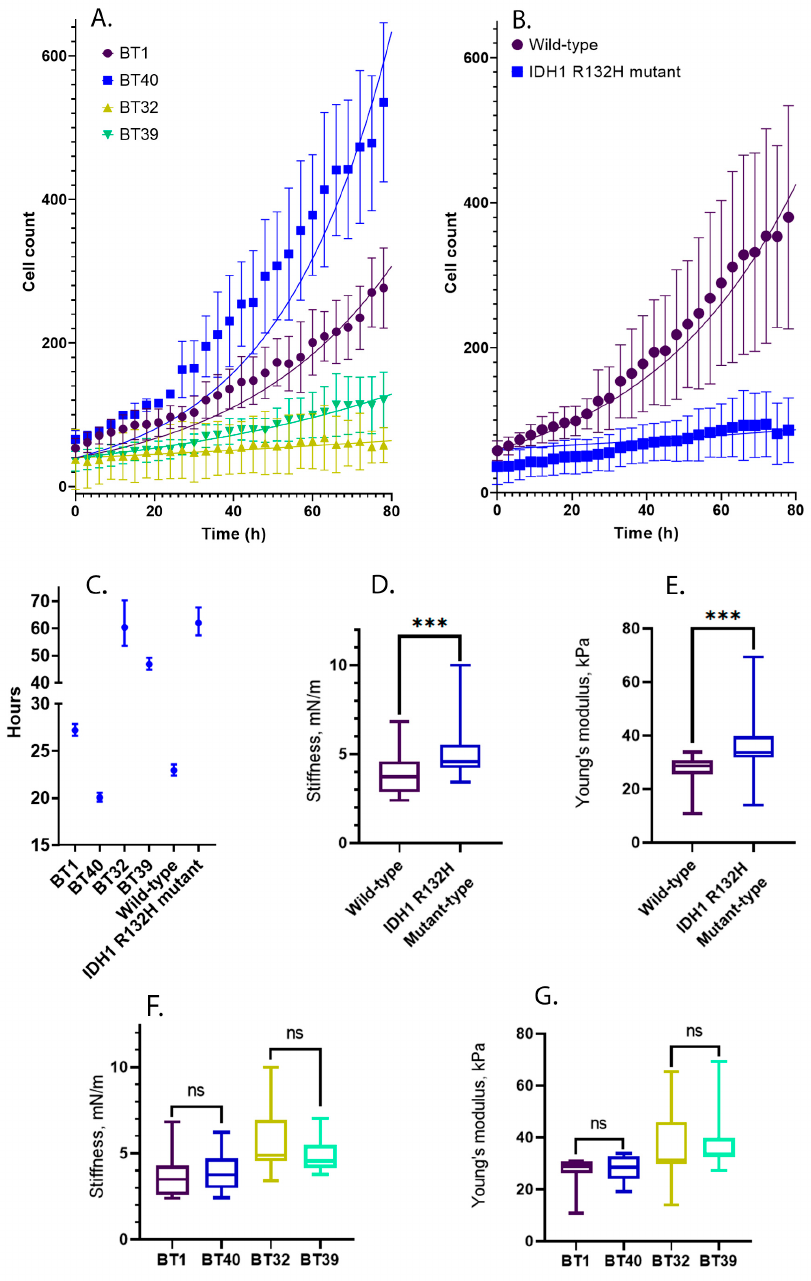
Figure 3. Cell proliferation rate for R132H mutant and wild type cell cultures. Asterisks indicate level of statistical significance: *** p ≤ 0.001 and “ns” p > 0.05. ( A ) Growth curves for the each analyzed cell culture; ( B ) Growth curves for the cell cultures grouped by the presence of IDH1 R132H mutations; ( C ) Cell doubling time calculated for the each analyzed cell culture and clustered cell cultures by the presence of IDH1 R132H mutation; ( D ) The comparison of the stiffness collected from whole populations of the cells from the IDH1 R132H cell cultures vs. wild type cell cultures. ( E ) The comparison of the Young’s modulus collected from whole populations of the cells from the IDH1 R132H cell cultures vs. wild type cell cultures. ( F ) The comparison of the cell stiffness measured from specific cell lines. ( G ) The comparison of the cell Young’s modulus measured from specific cell